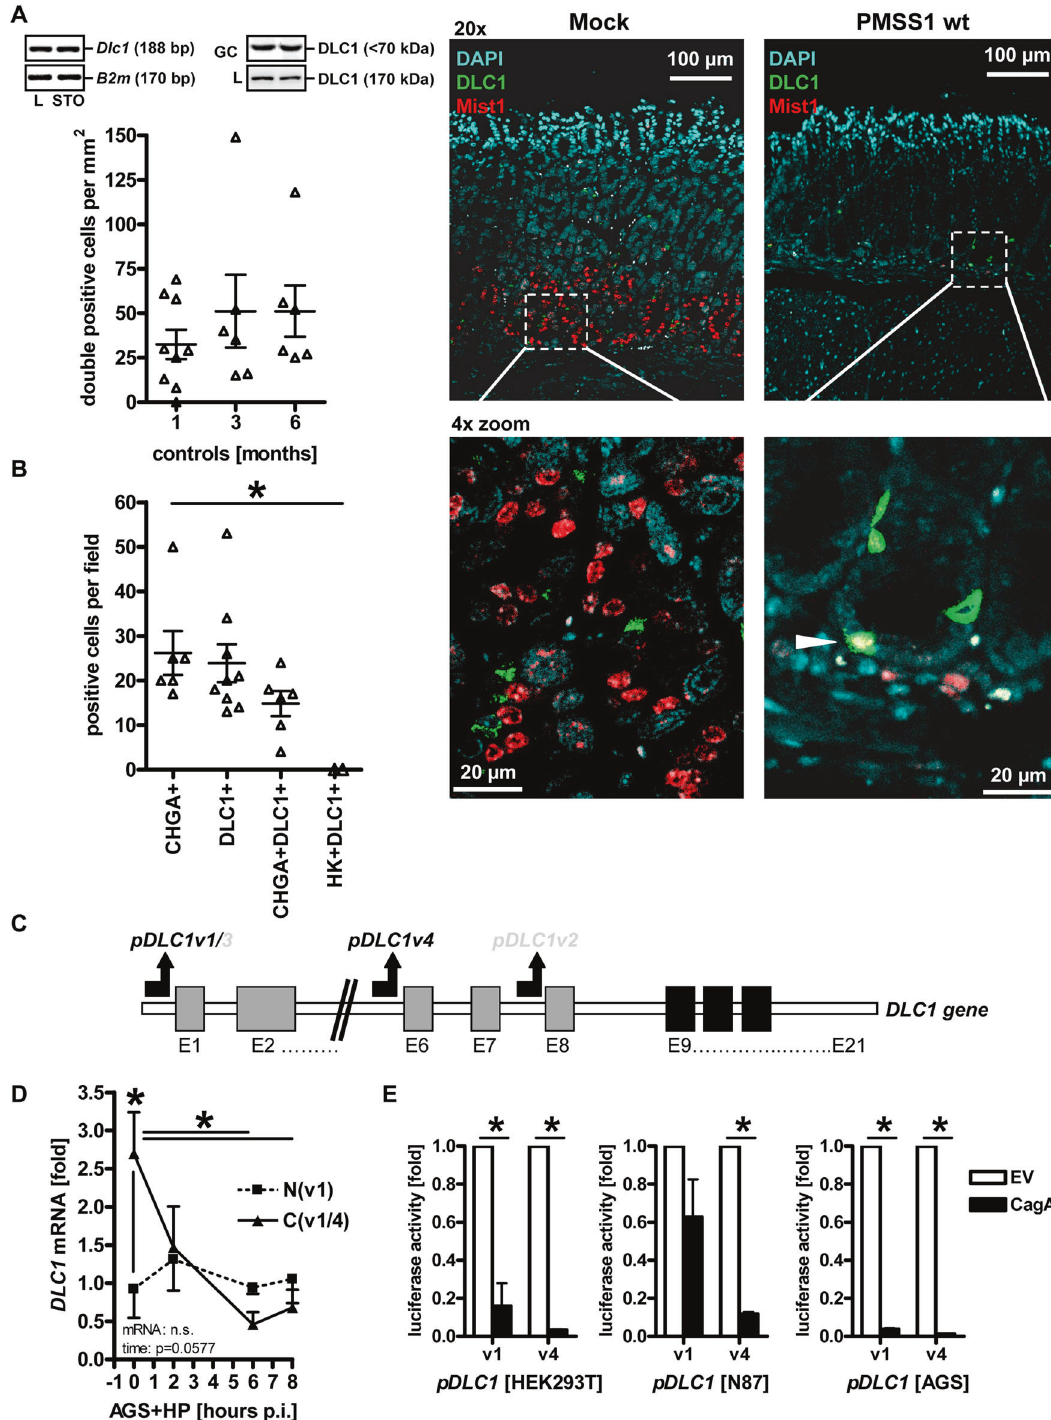
evidence indicating mutual functional antagonism of the two proteins, wherein DLC1 inhibits CagA-dependent RHO signalling and, vice versa, CagA prevents transcription from the DLC1 promoter, thereby lowering DLC1 protein in living cells. This cross-talk (Fig. 6E) was driven by protein-protein interaction mediated via the N- and C-terminal CagA domains and the internal/C-terminal regions of FL DLC1v1 and Δ SAM DLC1v4.